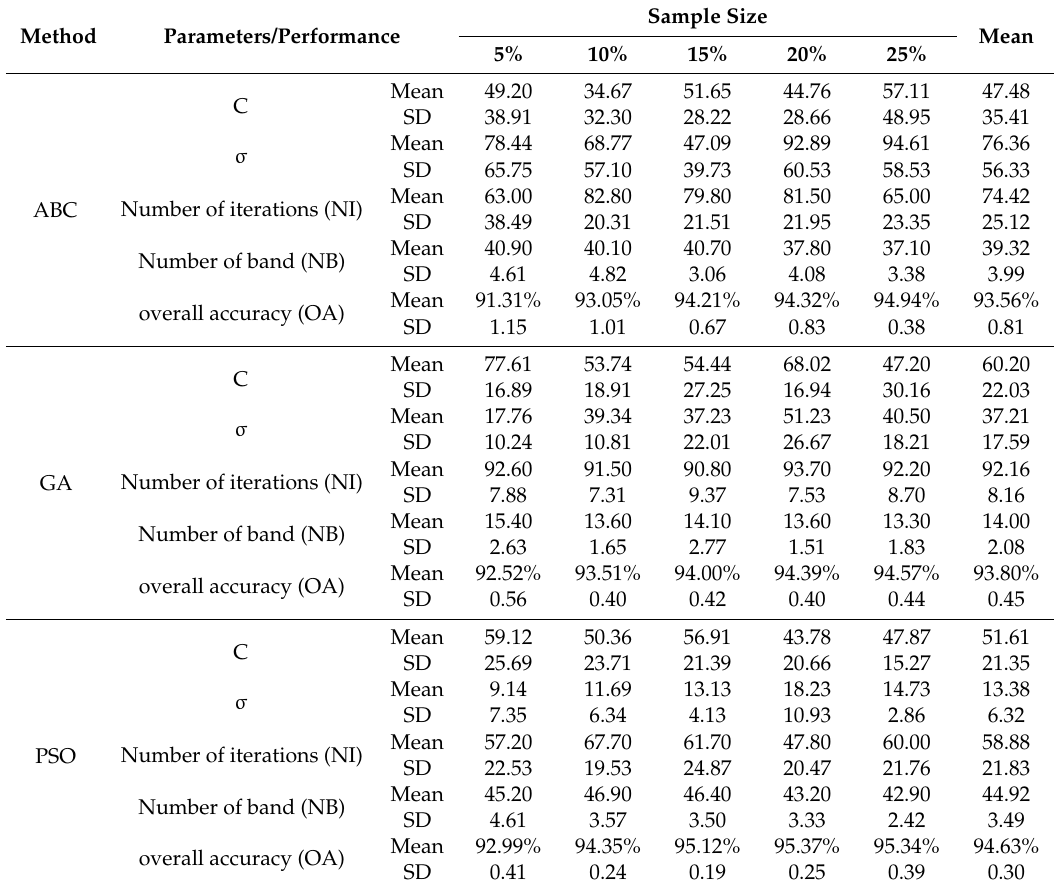
Table 1. Classification parameters and performance of the Pavia University image.